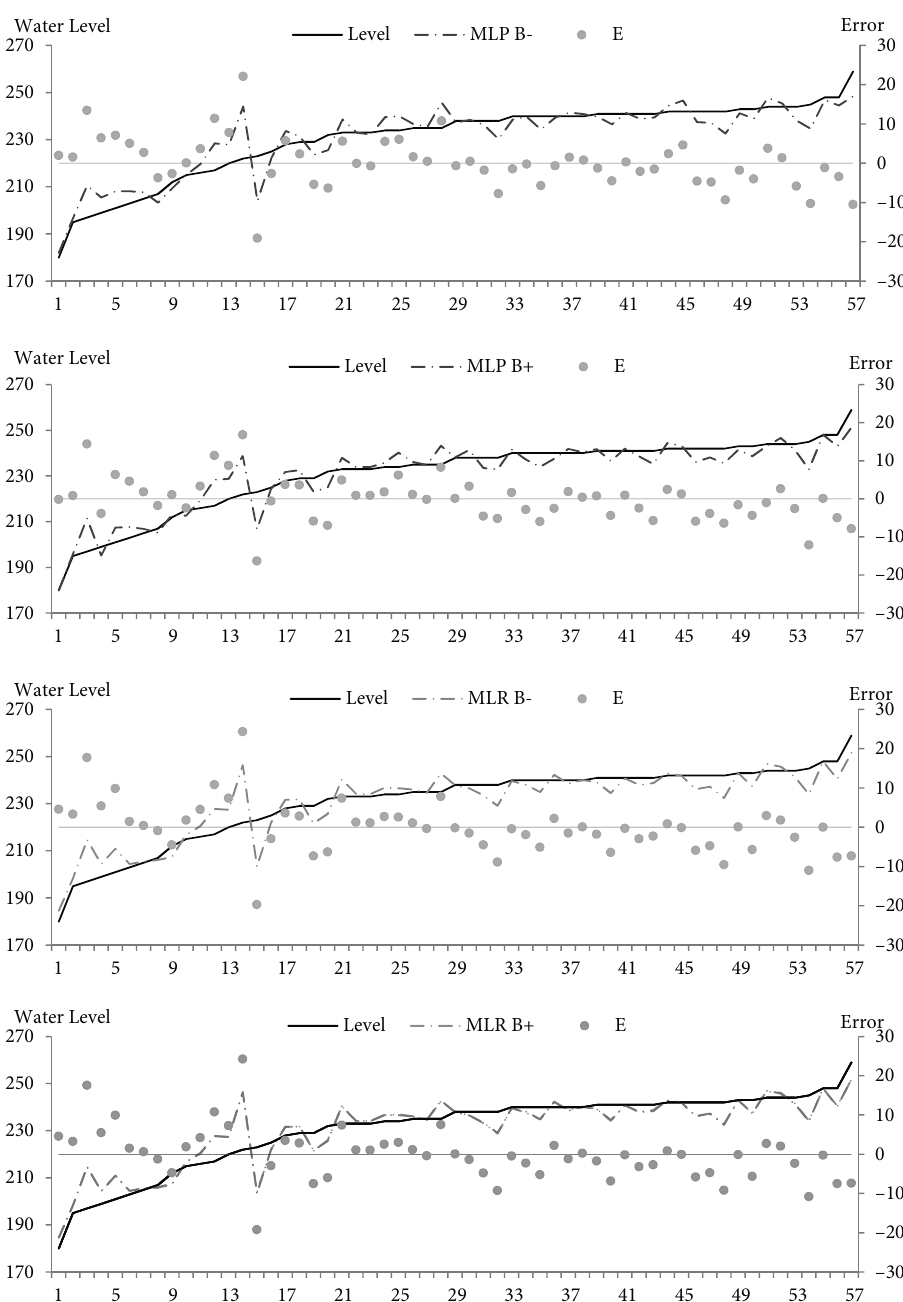
Fig. 5. Observed and forecasted values of water level for various models. Charts have been arranged from the lowest to the highest values of water level along with the forecasted water level and the value of relative